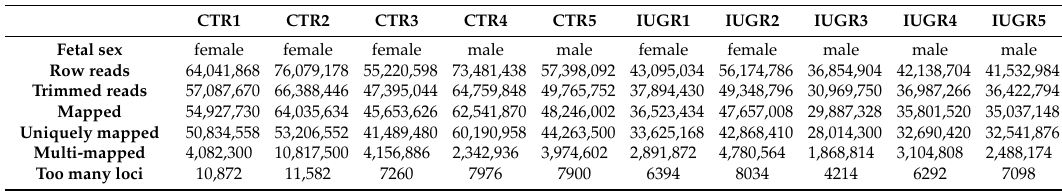
Table 1. Sequencing, quality control and mapping metrics for each placental control (CTR) and IUGR-affected library. Mapped reads were divided to uniquely (reads that map exactly one time on the genome), multi-mapped (reads that map 2–20 times on the genome) and to too many loci (reads that map more 20 times on the genome).